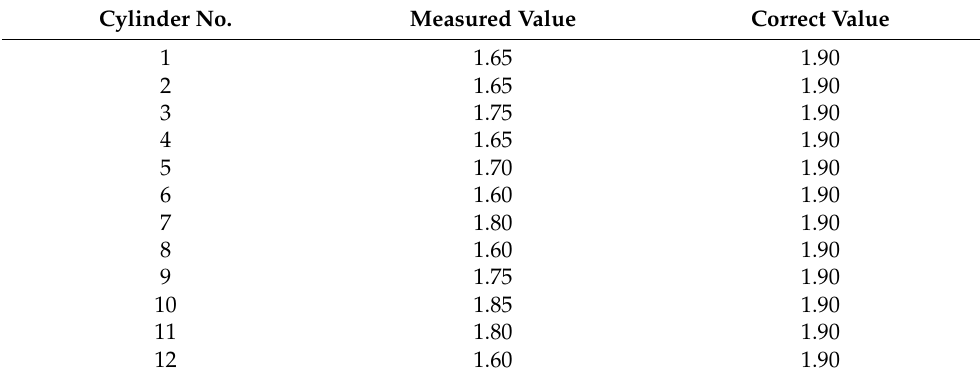
Table 5. Compression pressure in cylinders [MPa].